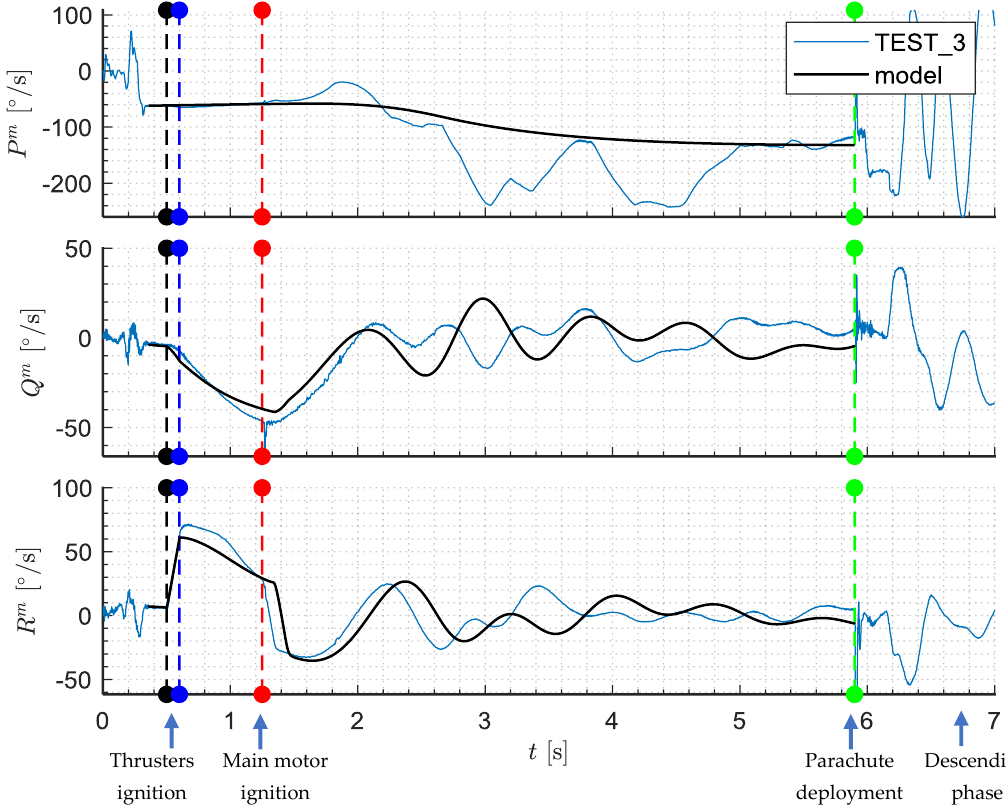
Figure 24. Angular rates (test 3, lateral thrusters before the center of mass).